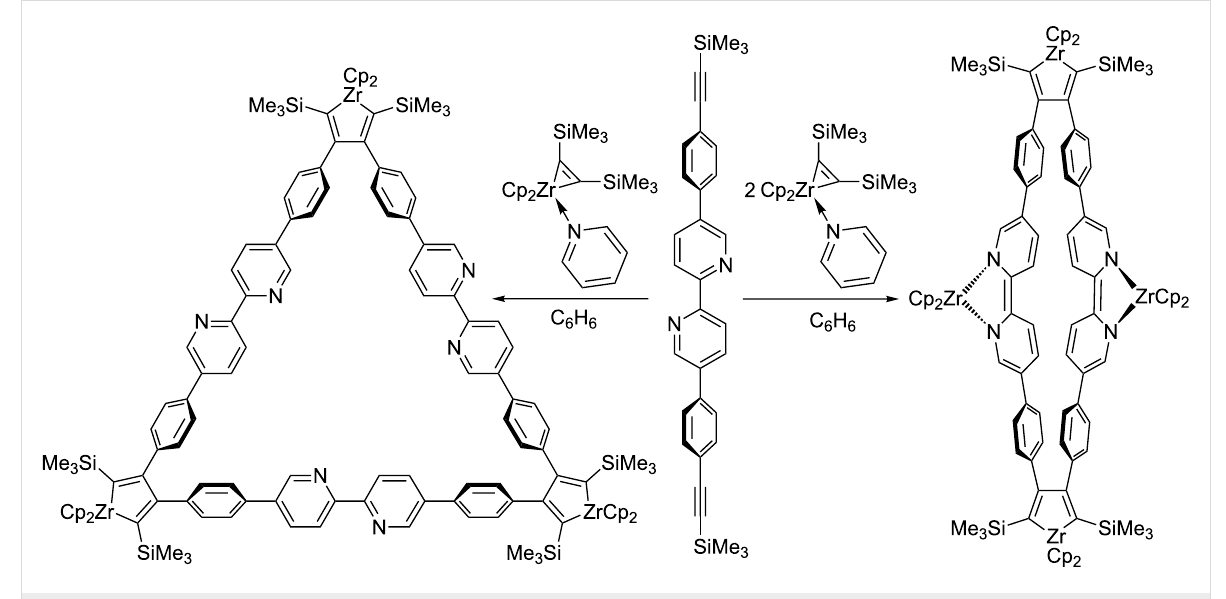
Scheme 1: Zirconocene-coupled dimeric (right) and trimeric (left) macrocycles